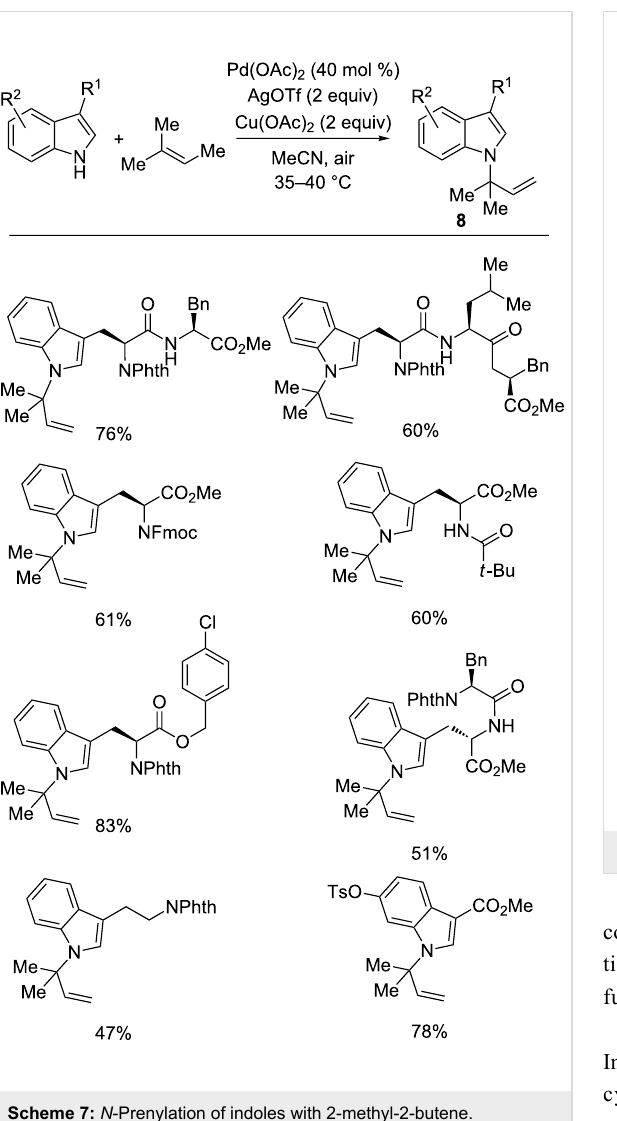
Scheme 7: N -Prenylation of indoles with 2-methyl-2-butene.